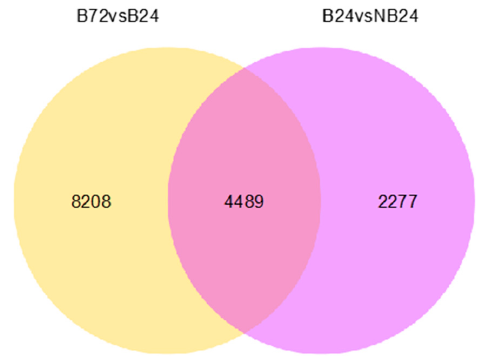
Figure 7. Venn diagram of differentially expressed genes (B24 vs. NB24 and B24 vs. B72). The numbers in each circle denote the total number of different genes in the comparison, and the overlapping sections denote the different shared genes between two